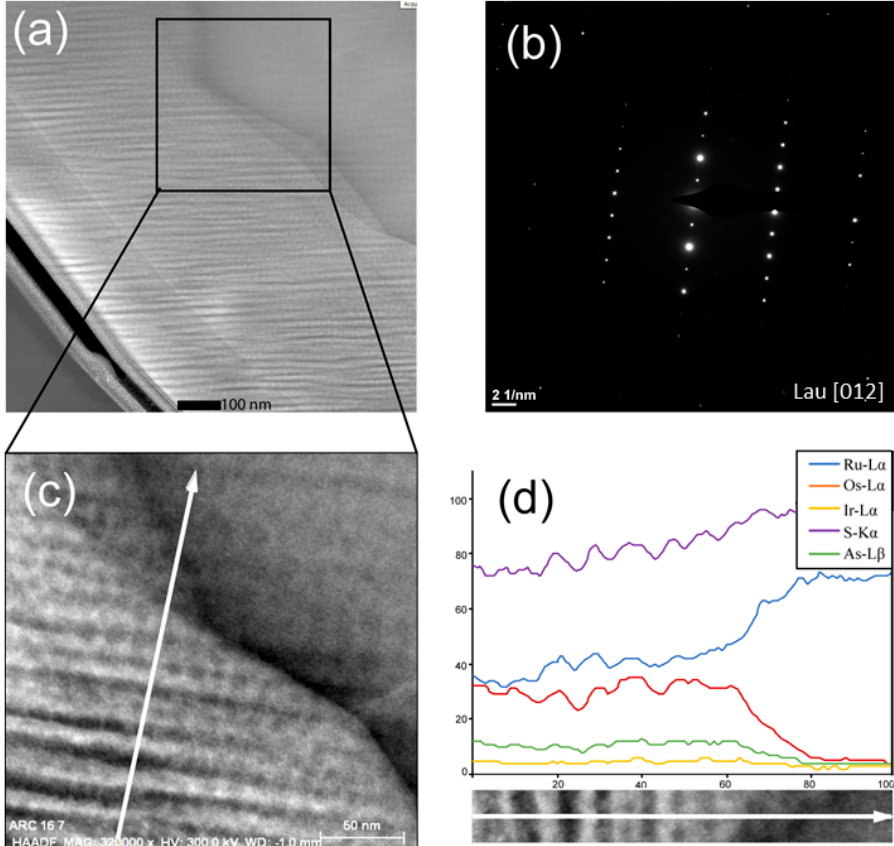
Figure 5. ( a ) HAADF image of the core-rim contact of the laurite thin-foil (ARC-16/7 grain). ( b ) Diffraction pattern obtained on the fringes domain showing a monocrystalline pattern of laurite. ( c ) Detail of the HAADF image of the rim to core contact of the laurite thin-foil. White arrow showing the direction of the EDX profile obtained. ( d ) EDX profile showing the compositional variations of Ru-L α , Os-L α , Ir-L α . S-K α and As-L β vs counts per second (cts).